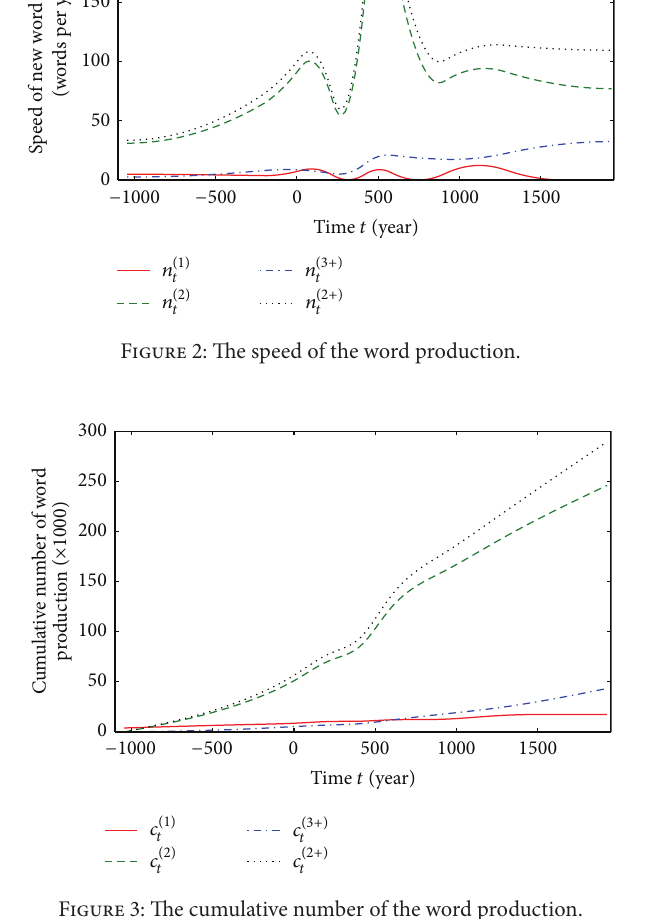
Figure 3: The cumulative number of the word production.